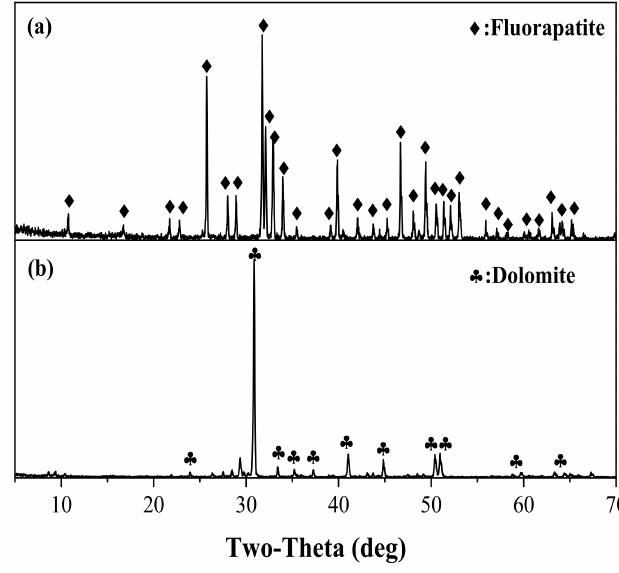
Figure 1. XRD patterns of ( a ) Fluorapatite and ( b ) Dolomite. Table 1. Chemical composition of fluorapatite (wt.%).